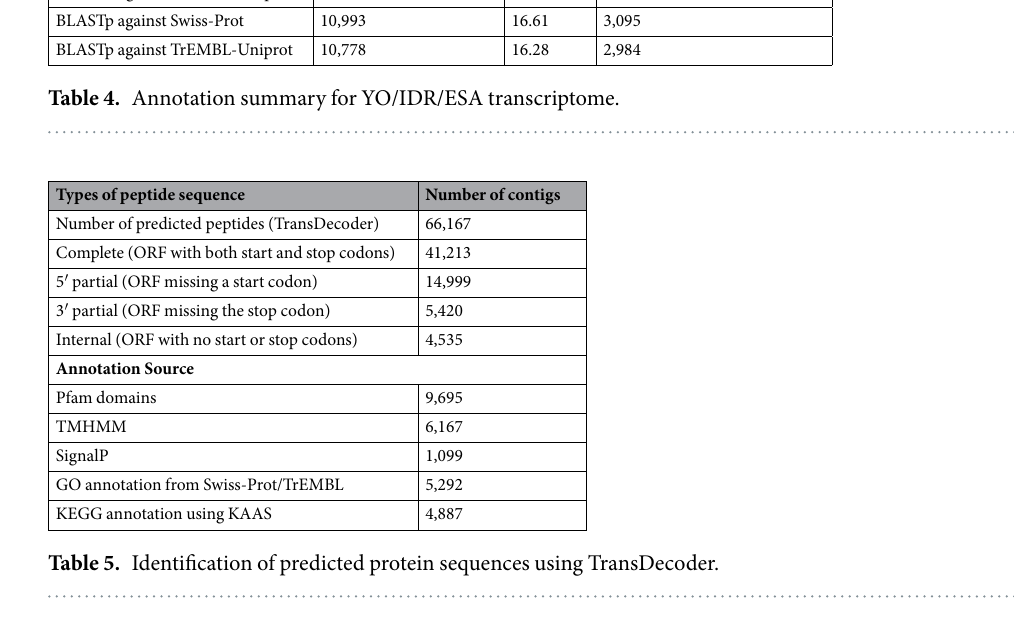
Figure 4B). Single organism process (GO:0044802) and biological regulation (GO:0065007) were the most highly represented terms in the biological processes category (Suppl. Figure 4C).